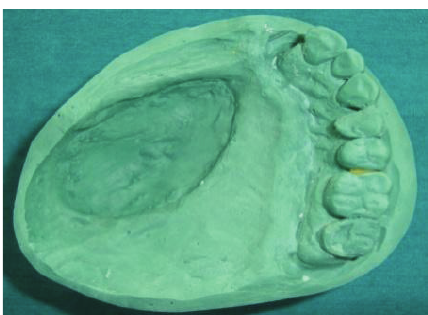
Figure 3: Adaptation of a layer of wax.